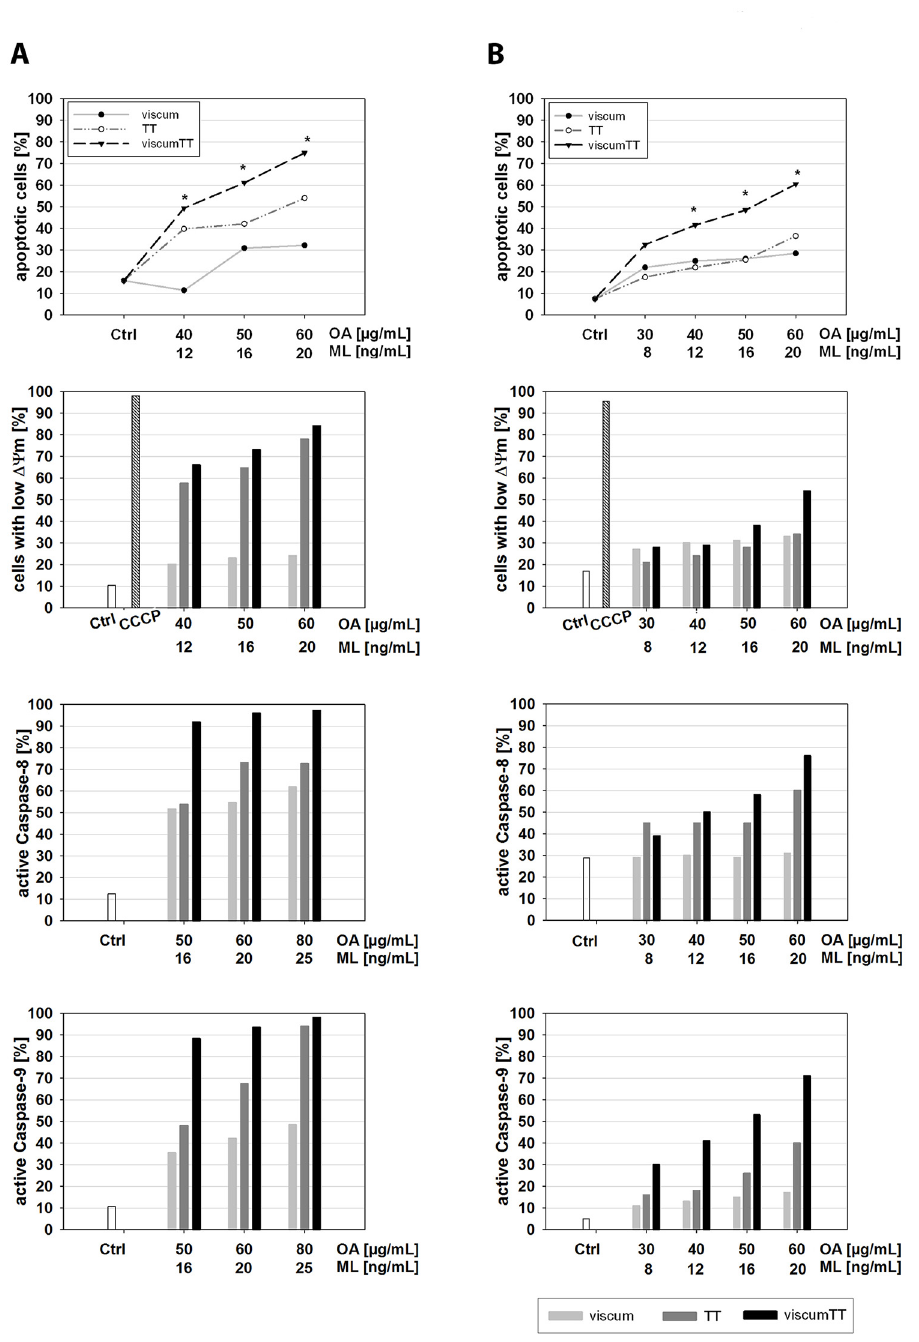
Fig 5. Mistletoe extracts induce apoptosis in acute myeloid leukaemia cells ex vivo . Mononuclear cells obtained from bone marrow aspirates of two patients with acute myeloid leukaemia (patient 1 (m; 17 years); patient 2 (m, 10 years)) were incubated with the depicted VAEs for 18 h. Induction of apoptosis (n = 2), mitochondrial transmembrane potential (n = 1) and activation of caspase-8 / -9 (n = 1) were measured by flow cytometry. VAEs induce apoptosis with involvement of mitochondria and activation of caspases in AML patients ex vivo , viscumTT shows synergistic apoptosis induction.